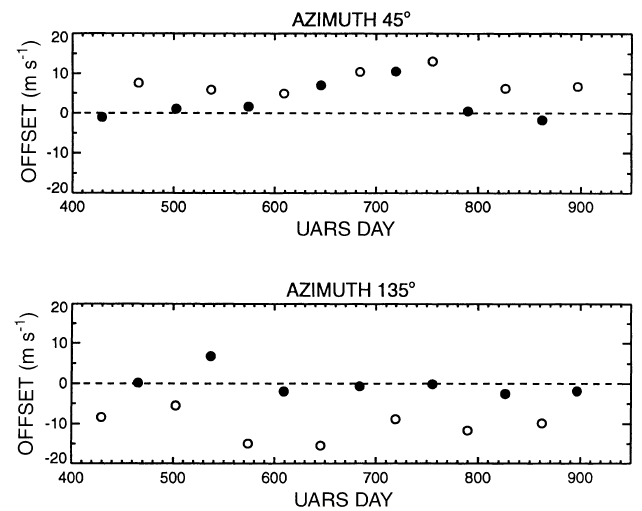
Fig. 11. WINDII-HRDI o(cid:128)sets for an altitude of 95 km in the 45 (cid:176) azimuth ( upper panel ) and 135 (cid:176) azimuth ( lower panel ) instrument LOS directions, averaged over each yaw cycle. Solid points denote WINDII FOV-1 and open points indicate